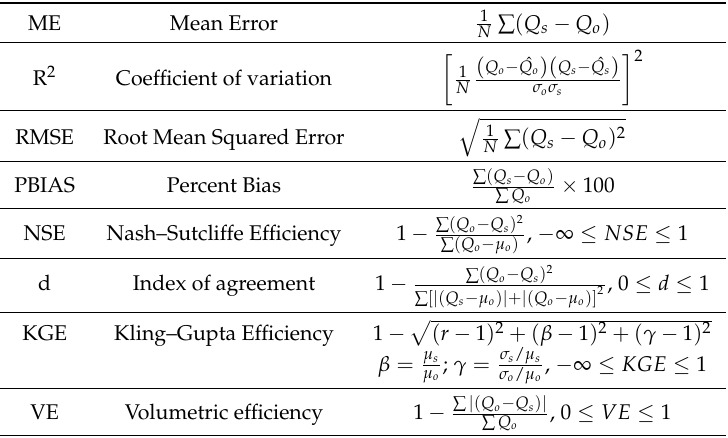
Table 2. Goodness-of-fit measures.